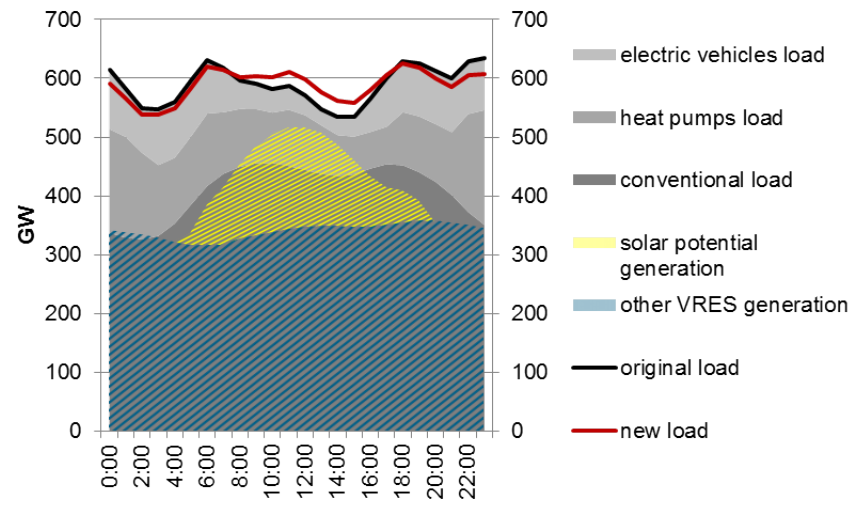
Figure 6. Total European load (before and after load shifting) and VRES potential profiles, averaged for each hour of the